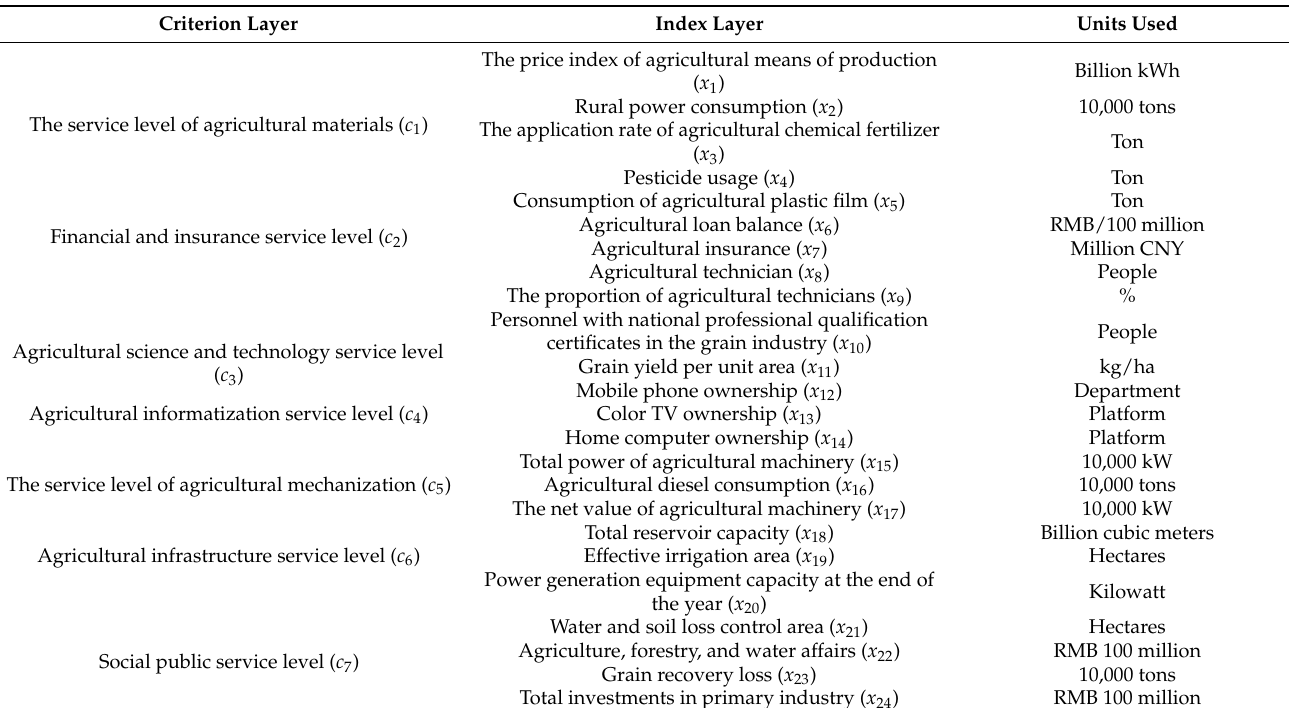
Table 1. Comprehensive evaluation index system of agricultural